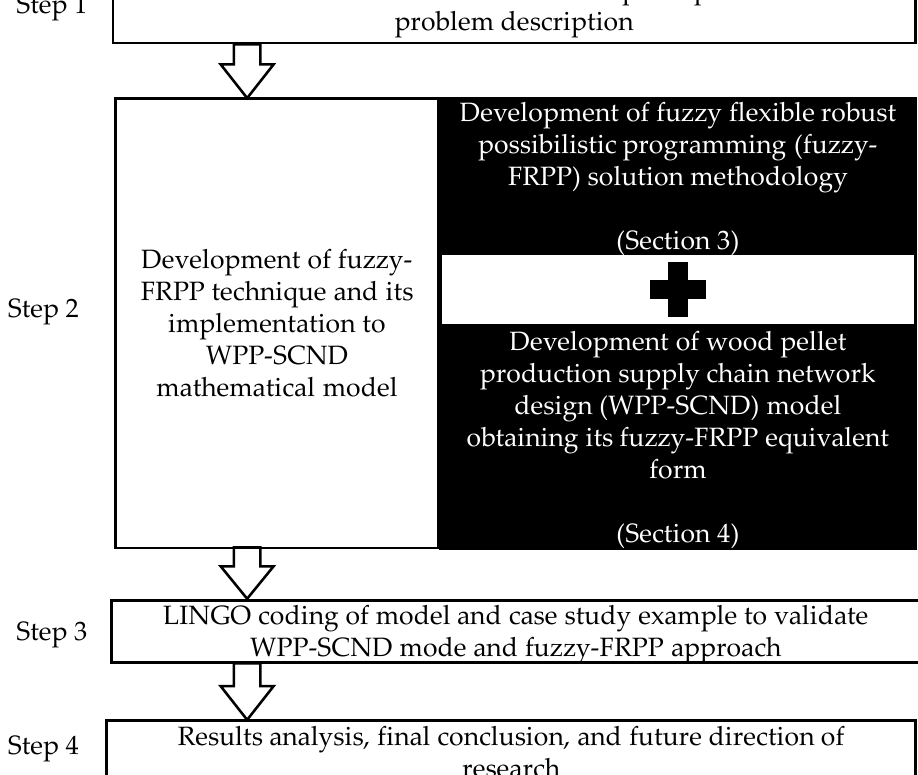
Figure 1. Research methodology employed for the study.